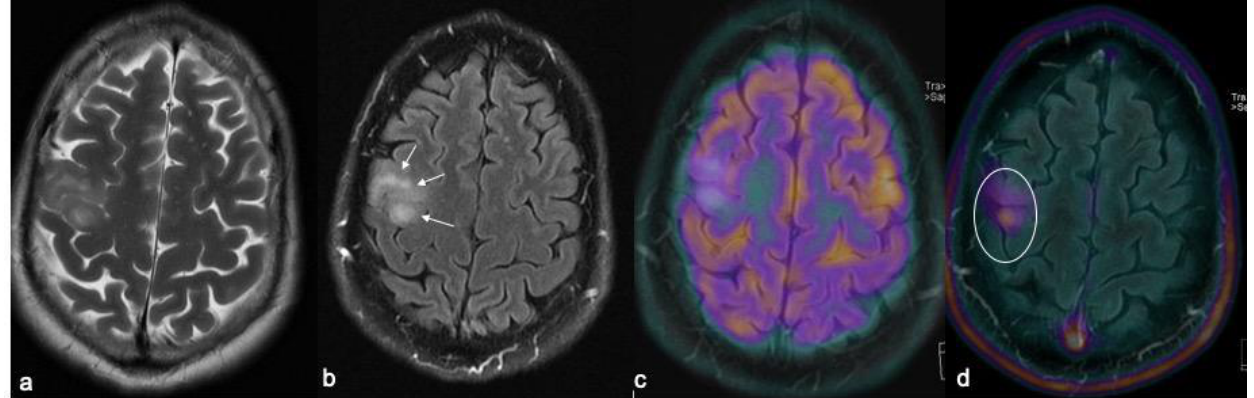
Figure 2. IDH-WT glioma with ill-defined borders in the posterior aspect of the middle frontal gyrus showing an inhomogeneous high signal on the T2w fast spin echo ( a ) and FLAIR (arrows in ( b )) sequences with no radiotracer uptake at FDG-PET ( c ), but demonstrating a noticeable uptake upon FET-PET examination (circle in ( d )).